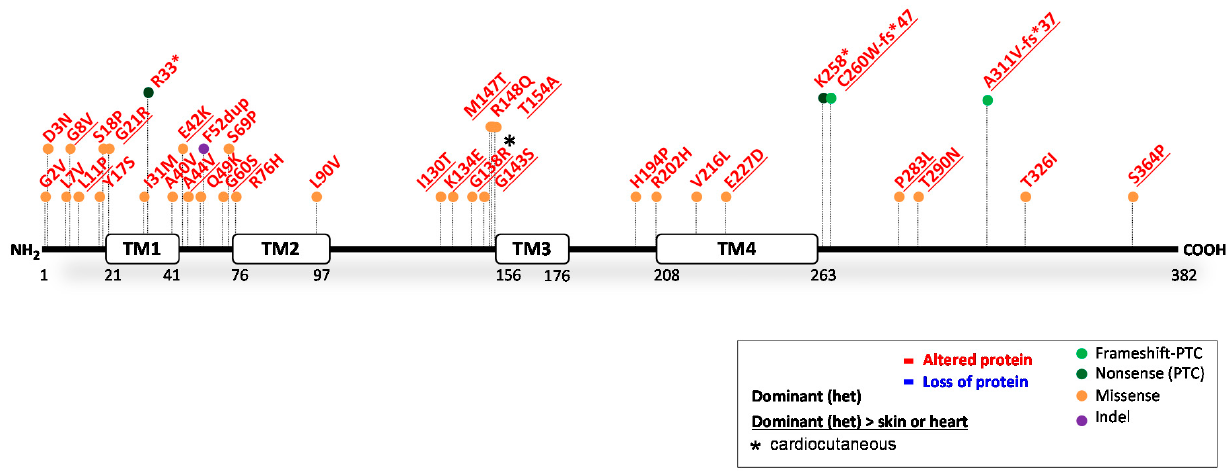
Figure 6. Location of functionally investigated GJA1 variants.